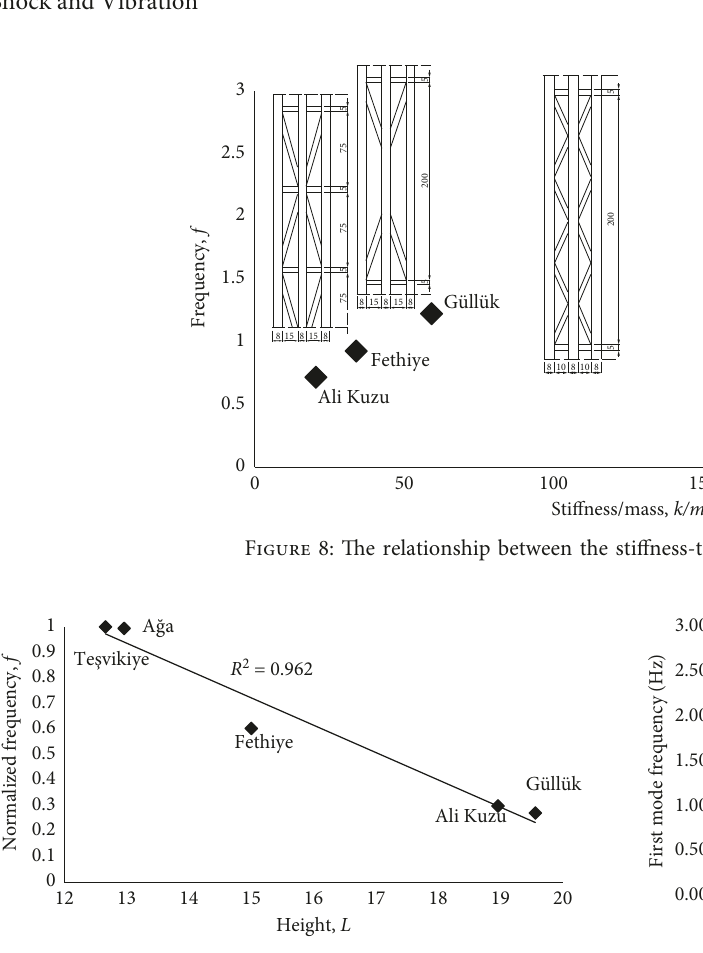
Figure 9: The relationship between the normalized frequencies and heights.